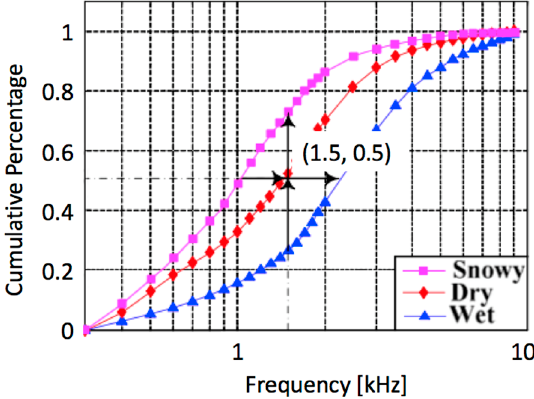
Figure 28. Typical cumulative spectral content of TPIN for different road conditions (modified from Kongrattanaprasert et al., 2010 [302], Figure 1; reprinted under fair use provision).